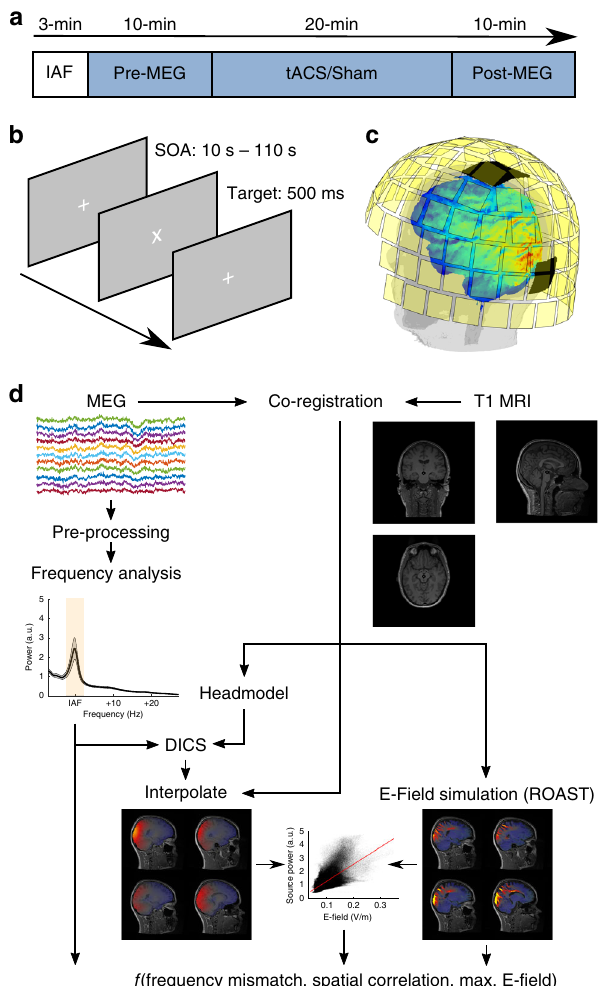
Fig. 1 Experimental design and analysis pipeline. a Time-course of the experiment. Prior to the main experiment, 3-min of eyes-open MEG were acquired to determine participants ’ individual α -frequency (IAF). After 10-min of baseline measurement, participants received 20-min of tACS at IAF with 1 mA (peak-to-peak) or sham stimulation. Another 10-min of post- stimulation MEG were acquired thereafter. b Visual change detection task. Participants were instructed to detect rotations of a white fi xation cross, presented on a screen at a distance of ~ 1 m. c MEG sensor array and tACS montage. MEG was acquired from 102 magnetometer and 204 planar gradiometers. Stimulation electrodes were placed centered above positions Cz and Oz of the international 10-10 system. d Analysis pipeline to obtain spatial correlation between participants ’ α -topography and electric fi eld as well as the maximum electric fi eld magnitude inside the gray and white matter compartments and the mismatch between tACS frequency and the dominant frequency during the baseline